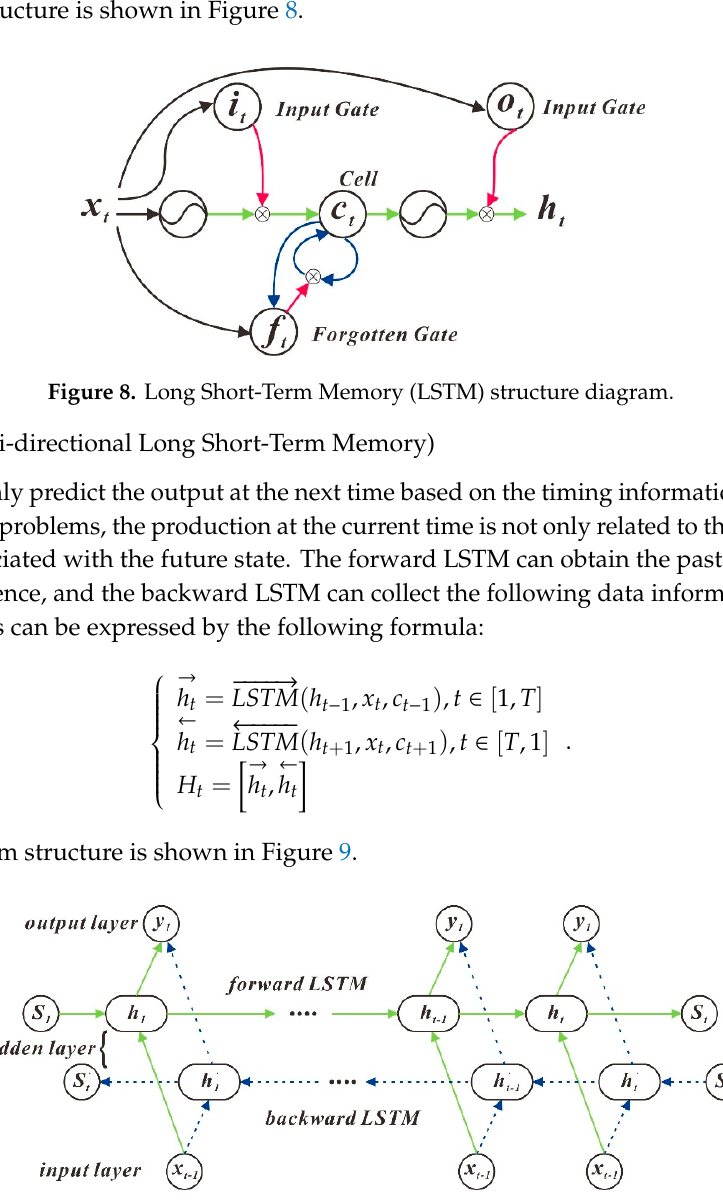
Figure 9. Bi LSTM structure diagram.